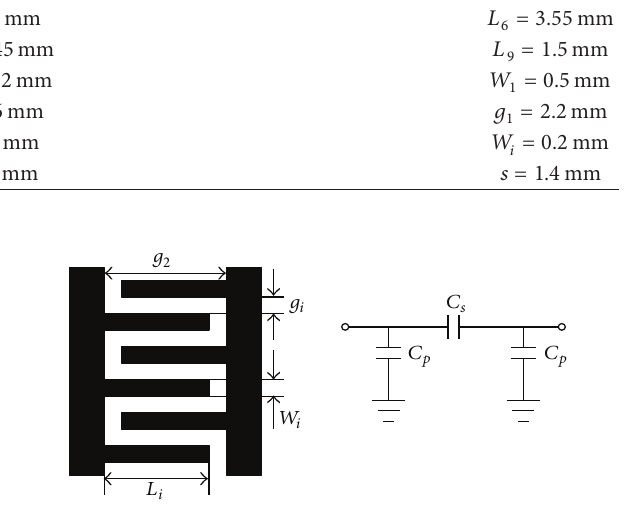
Figure 2: Interdigital coupling capacitor and its equivalent circuit.